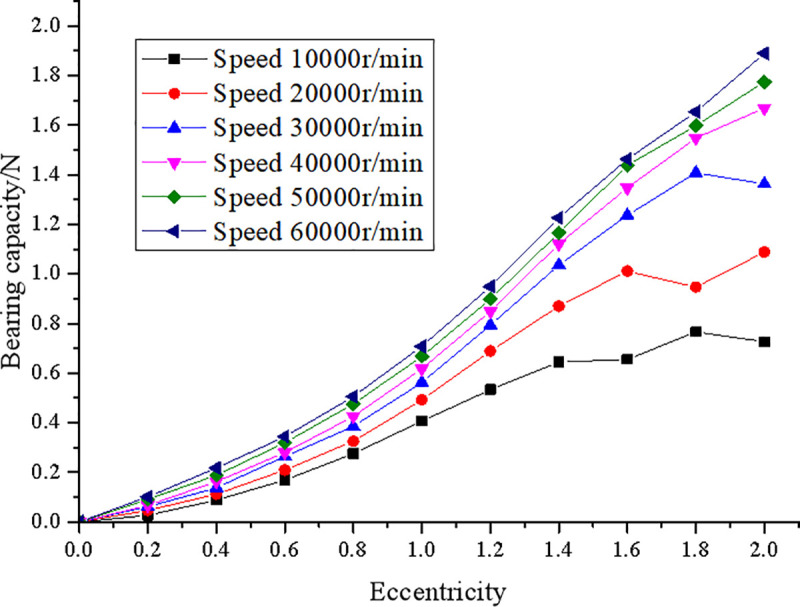
The influence of eccentricity on the capacity of the hybrid bearing system at different bearing rotating speeds.